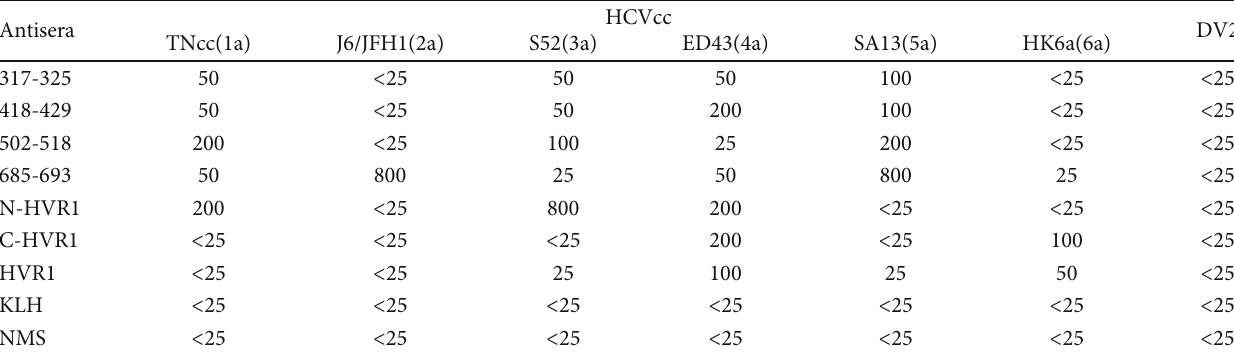
Mouse antisera of each group were pooled for neutralization tests. The NT 50 was de fi ned as the highest dilution of sera able to neutralize 50% of infection. The data are representative results from 3 independent experiments. NMS: normal mouse sera; DV2: Dengue virus Thai strain